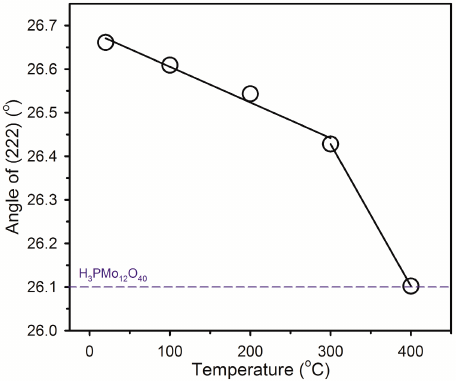
Figure 2. In situ XRD (X-Ray Diffraction) in air from ambient to 400 °C for the fresh APMV sample, ( left ) full range; ( right ) (222) line of APMV.